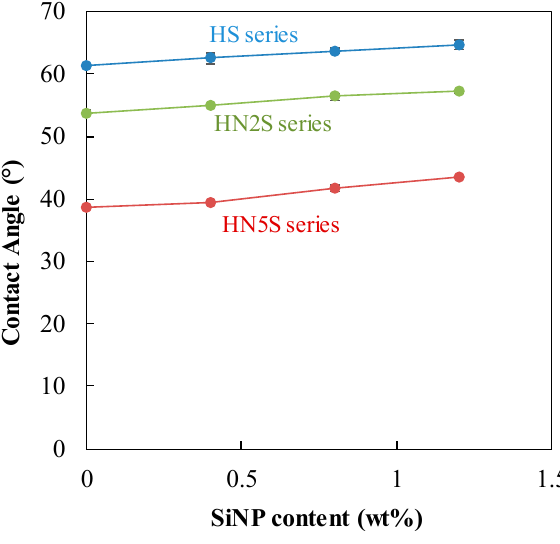
Figure 11. Contact angle of SiNPs samples.